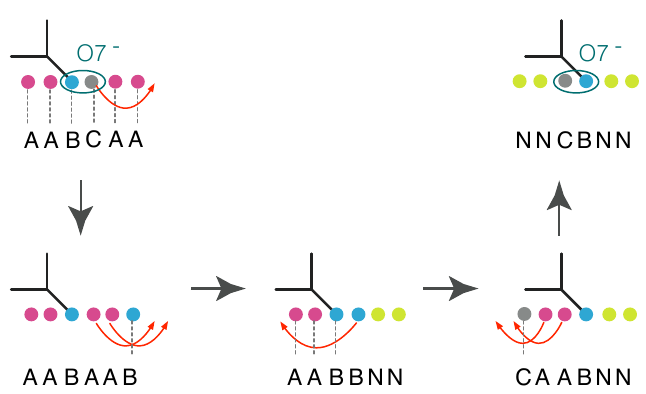
Figure 40 . (i) An SL(2 ; Z ) invariant 7-brane combination where B 7-brane is attached to 5-brane. A sequence of monodromy analysis makes A 2 BCA 2 into N 2 CBN 2 which will be converted into A 2 BCA 2 again via an S-dual